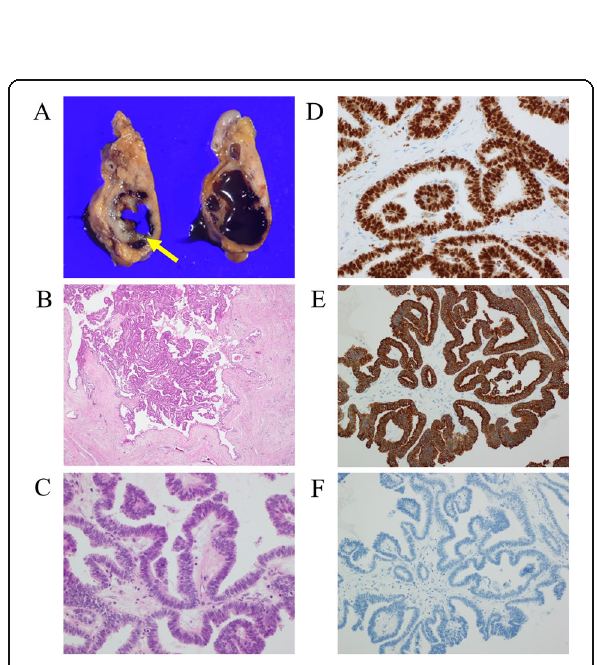
Fig. 4 Histopathological findings of pancreatic tumors. a Macroscopic findings showed that the tumor comprised of a cystic wall and mural nodule, which contained cystic fluid. b Hematoxylin- eosin staining (× 40). Papillary tumors were growing in large cysts. Tumor cells had no mucus in the cytoplasm and had different characteristics from intraductal papillary mucinous neoplasm. The papillary structure was similar to that of the previously resected lung cancer tissue. c Hematoxylin-eosin staining (× 200) showed the power field of a . d Multiplex immunohistochemical staining (× 400), using specific antibody cocktails of TTF-1 and Napsin A. Nuclear expression of TTF-1 and granular cytoplasmic expression of Napsin A were seen. e CK7 was positive by immunohistochemical staining.